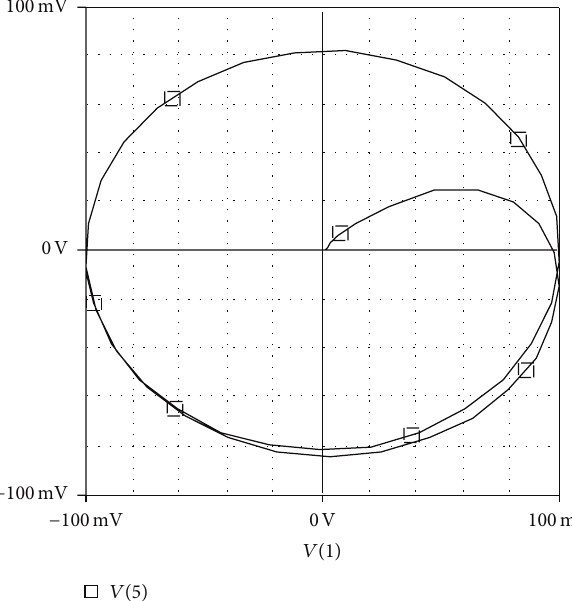
Figure 5: 𝑋 - 𝑌 plot showing 90 ∘ separations of input and output at pole frequency.